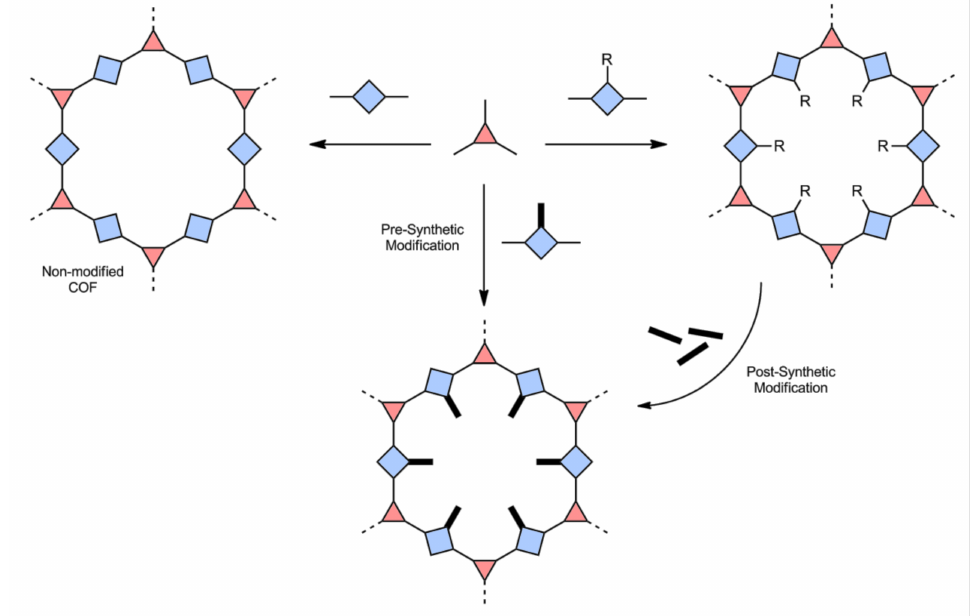
Scheme 3. Representation of COF building pathways, adapted from Dogru